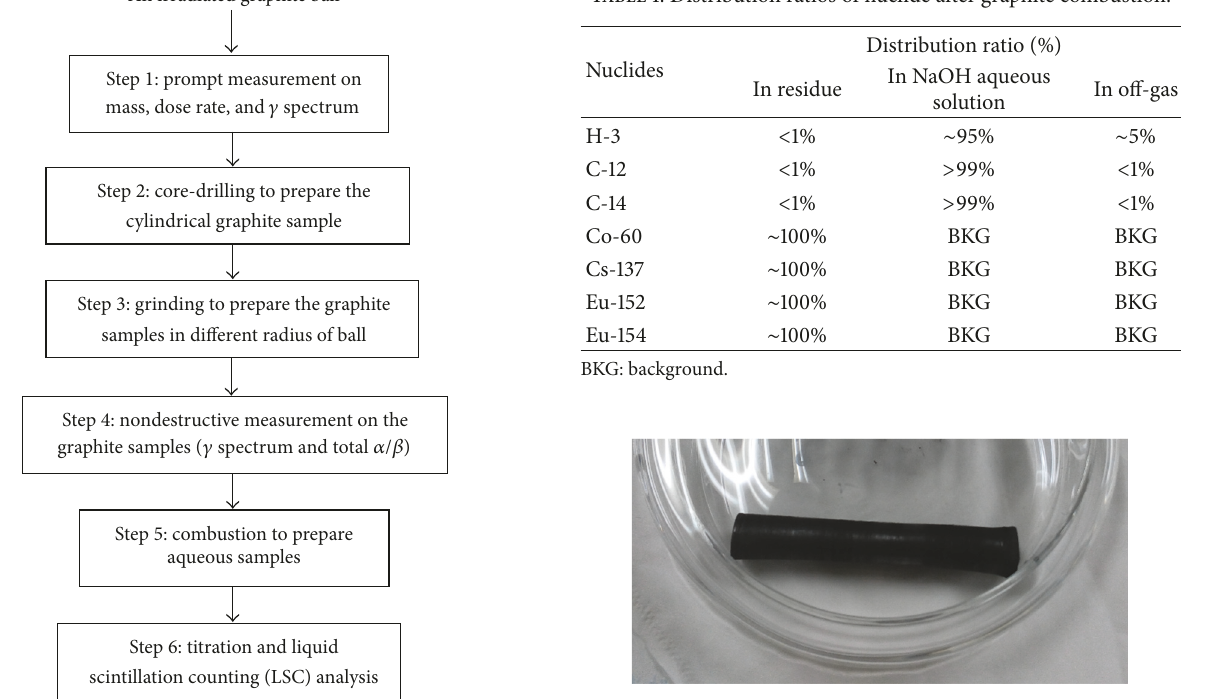
Figure 4: The cylindrical graphite sample prepared after